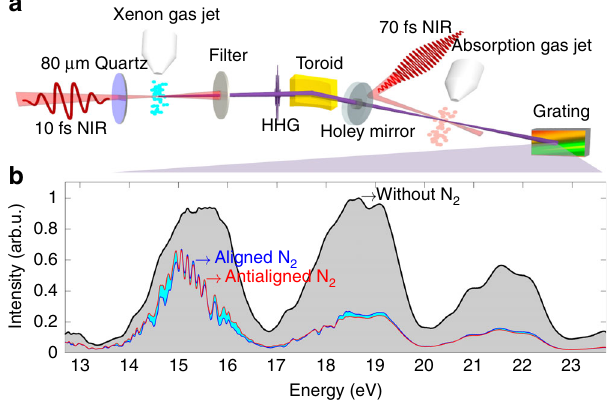
Fig. 1 Experimental setup and XUV spectra. a Schematic of the experimental setup. A broad XUV spectrum is generated by focusing a 10 fs NIR pulse into a xenon gas jet to generate an attosecond pulse train. The XUV is refocused in a second gas jet containing the target gas. A longer NIR pulse is used to impulsively align the molecules in the second gas jet. b XUV spectra taken without the target gas (black curve), after absorption by N 2 at the delay times corresponding to alignment (blue curve) and anti- alignment (red